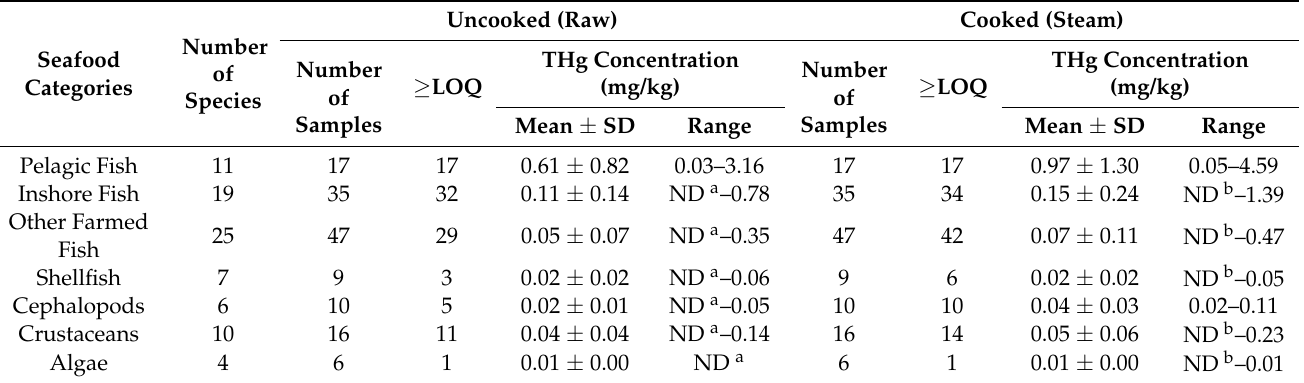
Table 4. Total mercury (THg) concentrations in raw (uncooked) and cooked